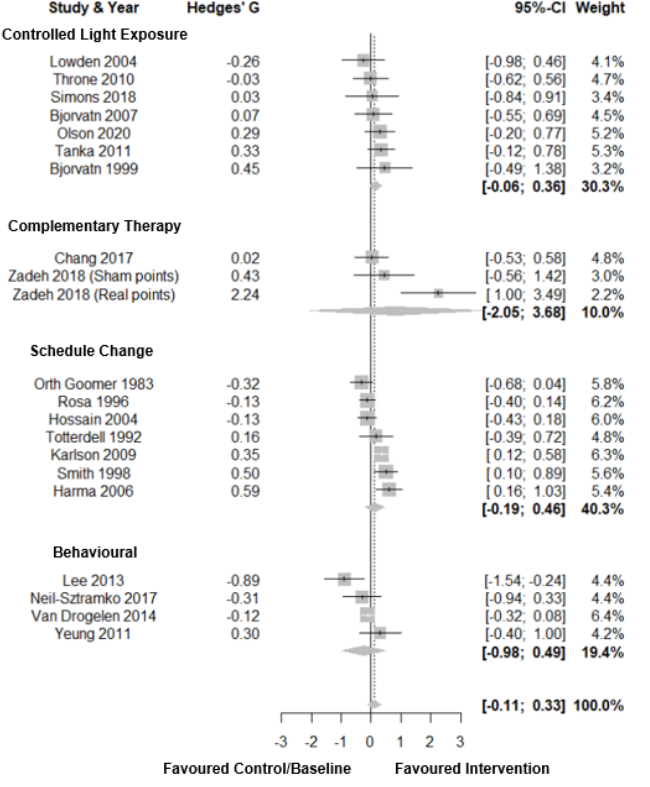
Figure 7. Forest plot for intervention by type on subjective sleep duration.